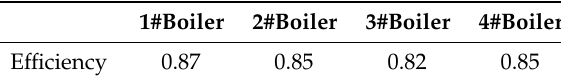
Table 2. Parameters of boilers.